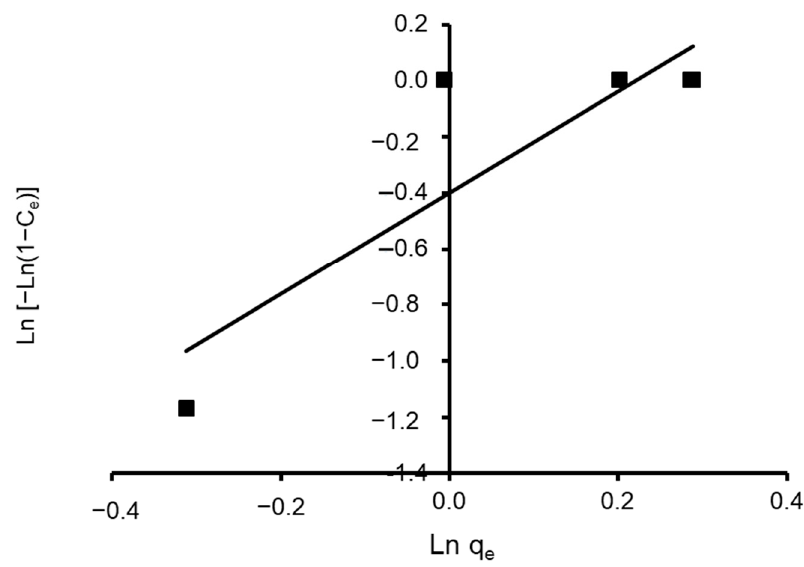
Figure 14. Plot of the Henderson isotherm model for CVD adsorbed onto S. costatum .